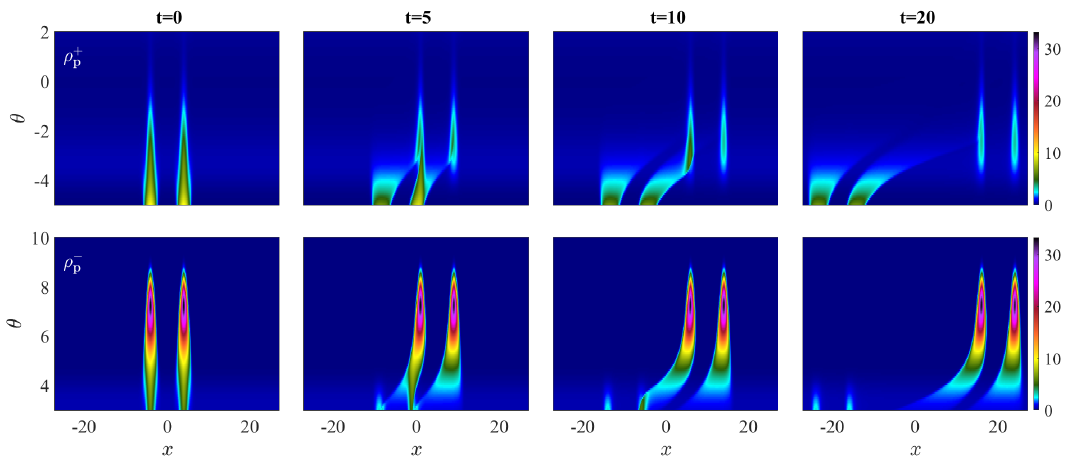
Figure 18 . Spectral density close ups of particle ( + ) (row 1) and particle ( − ) (row 2) for σ = 10 , α m = 7 , α a = 3 and x 0 = 4 . t = 0 : two subsidiary peaks of particle ( + ) and two interacting peaks of particle ( − ) are identical. t = 5 : the left subsidiary peak of particle ( + ) acquires additional particles from the right interacting peak of particle ( + ). t = 10 : the right subsidiary peak of particle ( + ) is persistent whereas the left peak is still decaying. t = 20 : the right persistent peak of particle ( + ) aligns in coordinate space with a larger magnet, the right interacting peak of particle ( − ). As a result, the right persistent peak of particle ( + ) is larger than the left (see the cross-sections shown in the figure 19).